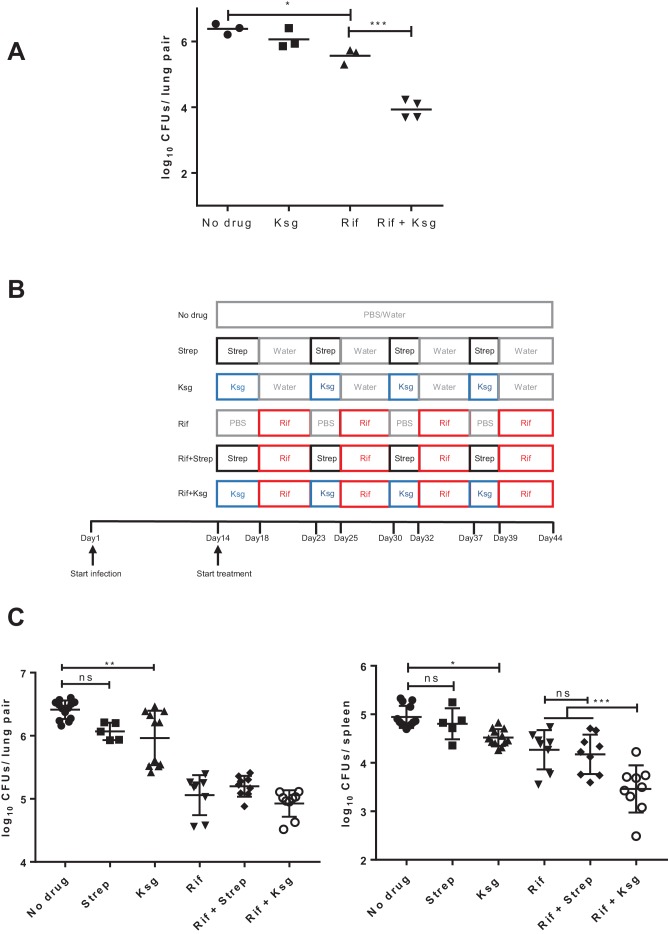
Kasugamycin enhances in vivo killing of M.tuberculosis by rifampicin.(A) Lung burden of Mtb-infected mice treated for 2 weeks with rifampicin (10 mg/kg), Ksg (400 mg/kg) or combination of the two. (B) Schematic of the sequential Ksg (400 mg/kg)/rifampicin (10 mg/kg) or Streptomycin (3 mg/kg)/rifampicin (10 mg/kg) dosing schedule. (C) Lung (left panel) or spleen (right panel) burden of Mtb-infected mice treated for 4 weeks as per the schedule in (B). Each data point represents bacterial organ burden from a single mouse. *p<0.05, **p<0.01, ***p<0.001, ns = not significant by one-way ANOVA followed by Tukey’s post-hoc multi-comparison correction. Only key comparators are shown for clarity, complete statistical analysis is shown in Supplementary file 2.